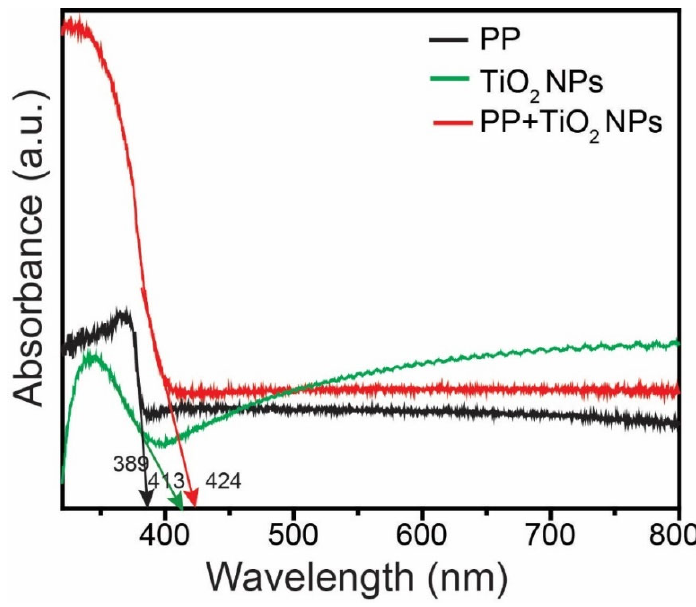
Figure 8. UV–Vis DRS spectra of PPM, TiO 2 NPs, and PPM + TiO 2 NPs. The recombination rates of the PPM, TiO 2 NPs, and PPM + TiO 2 NPs were evaluated by PL analysis. The PL plots of the PPM, TiO 2 NPs, and PPM + TiO 2 NPs samples were collected over a scanning range from 300 to 800 nm (Figure 9). The peaks of maximum intensity in the plots of the PPM, TiO 2 NPs, and PPM + TiO 2 NPs samples are observed at a λ max of approximately 381–398 nm owing to the band–band PL phenomenon. Furthermore, because of the TiO 2 NPs on the surface of the PPM in the PPM + TiO 2 NPs, the emission intensity in the PL spectra of the PPM + TiO 2 NPs was considerably reduced compared to that of the PPM and TiO 2 NPs. This result indicates that the recombination of the photo-induced charge carriers in the PPM + TiO 2 NPs is lower than that in the others. The diminished electron–hole pair recombination increases the separation and transfer of the photoexcited charge carriers, which boosts the activity of the product [34].